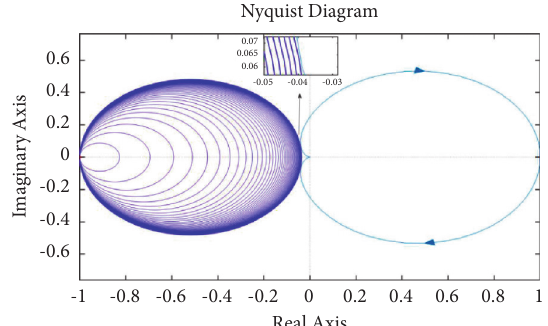
Figure 3: The Nyquist diagram with ω